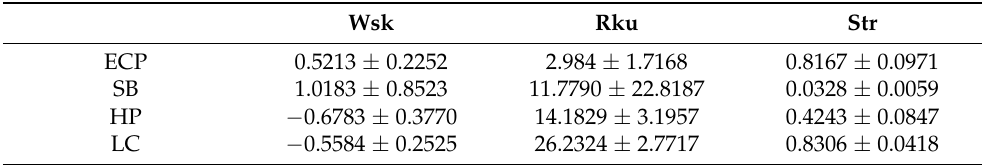
Table 1. Values for the skewness (Wsk), kurtosis (Rku), and aspect ratio of the surface texture (Str). Data are presented as means ± SD ( n = 9). Wsk Rku